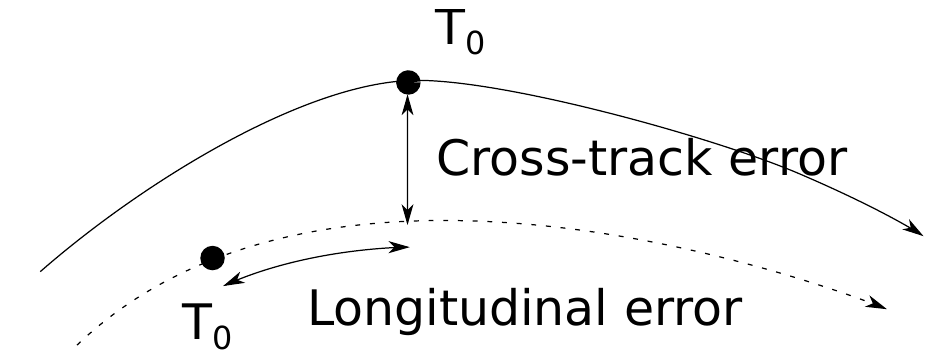
Figure 1. Longitudinal and cross-track